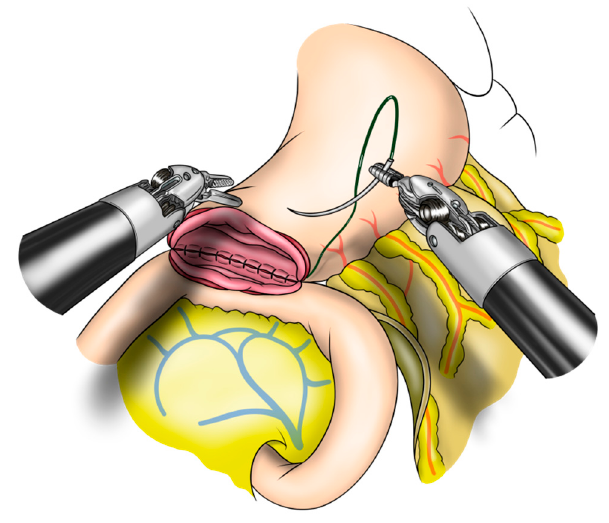
Figure 1. Robot-sewn gastrojejunostomy anastomosis in robotic pancreatoduodenectomy.